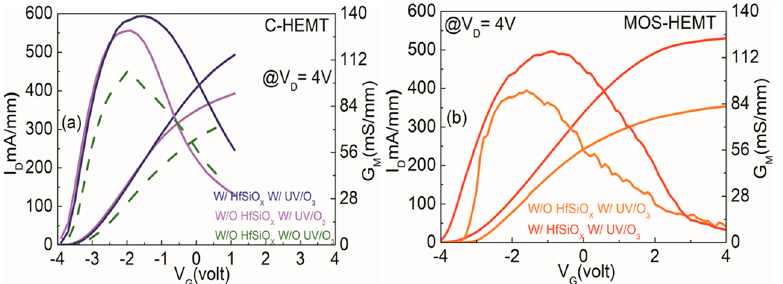
Figure 4. Comparison of transfer characteristics (I D -V G ) (@ V D = 4V) of ( a ) C-HEMT (before and after UV/O 3 treatment) and ( b ) MOS-HEMT with and without HfSiO X